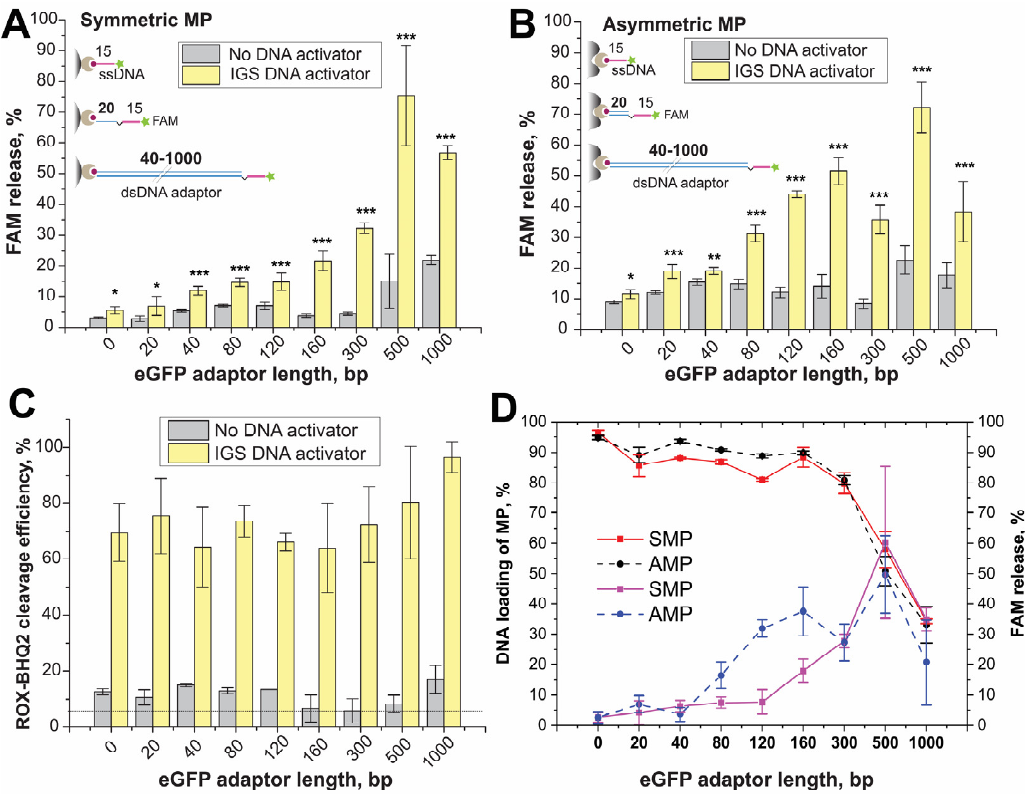
Figure 3. Trans-cleavage of trans-targets conjugates differing the eGFP adaptor length for ( A ) SMPs, ( B ) AMPs. Unpaired t -test p -values for corresponding raw signals are shown as asterisks: *- p < 0.1, **- p < 0.05, ***- p < 0.001 ( C ) Trans-cleavage of ROX–dT15–BHQ2 probe (100 nM) as internal control dash line represents the ROX–BHQ2 signal in the buffer. ( D ) Dependencies of trans-cleavage efficiency (blue and purple lines) and ds-ssDNA loading of MPs (red lines) on adaptor length. The values of negative controls were subtracted. The fluorescence of the released FAM after cleavage was normalized to an effective concentration of DNA targets in the conjugate and estimated as % of the released FAM.